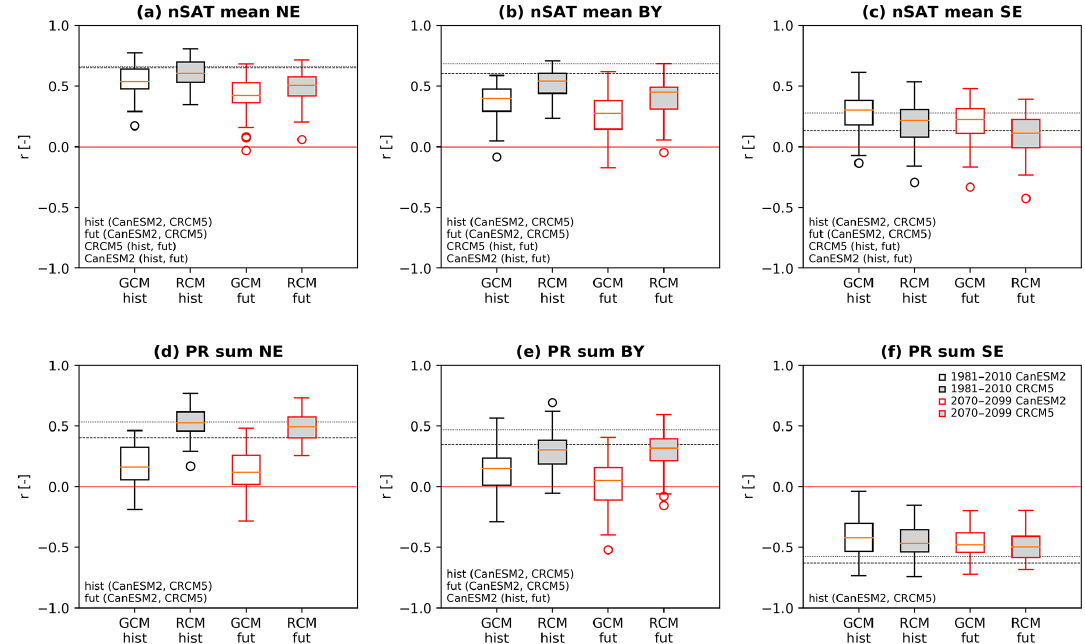
Figure 10. Boxplots of nSAT mean (a–c) and PR sum (d–f) showing Pearson correlation ( r ) with the NAO index of 50 CanESM2-LE (white filling) and CRCM5-LE (grey filling) realizations for three regions (NE, BY, SE) in historical (black outlines) and future (red outlines) time horizons. Dashed (dotted) horizontal lines indicate the ERA-I (CRCM5/ERA-I) value; text denotes combinations of which the differences are significant at p ≤ 0 . 05 using an unpaired Mann–Whitney/ U test for the comparison between hist and fut periods and a paired Wilcoxon test for the comparison between CanESM2-LE and CRCM5-LE. Orange line in boxplots is the median. For regions NE, BY and SE, see Fig. 2.